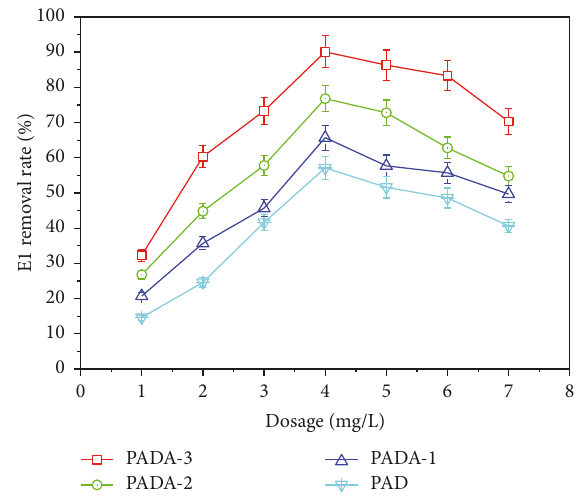
Figure 7: The effect of flocculant dosage on the E1 removal.